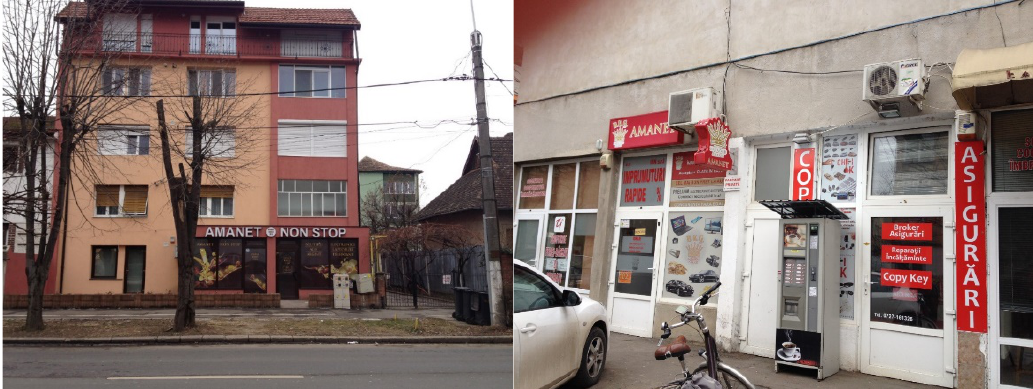
Figure 3: Pawn shops with attractive offers for gamblers (left & right) Source: Sorina VOICULESCU,